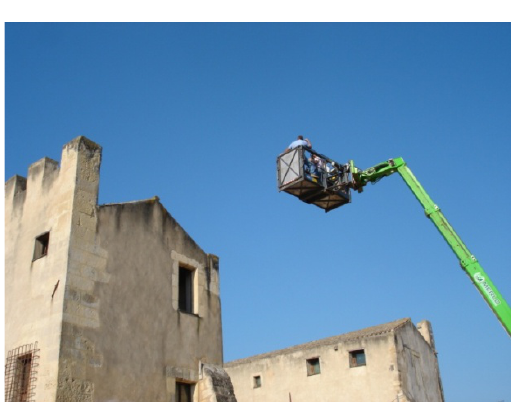
Figure 3: Airbone platform survey